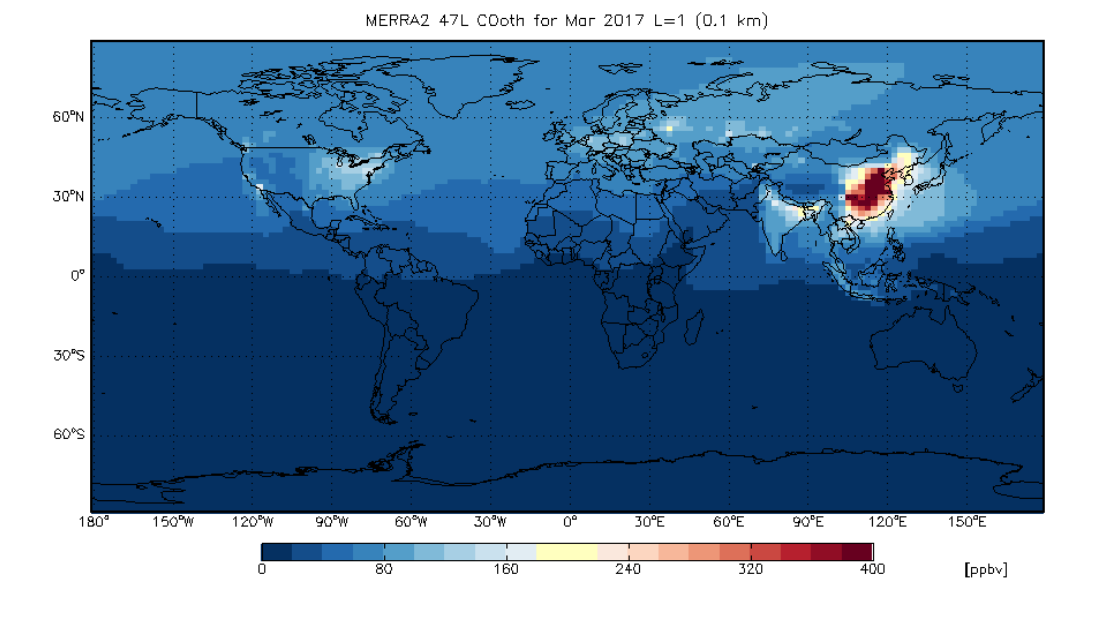
Figure 10. A snapshot of the fossil fuel contribution to the surface CO concentrations used in the tagged tracer simulations for March